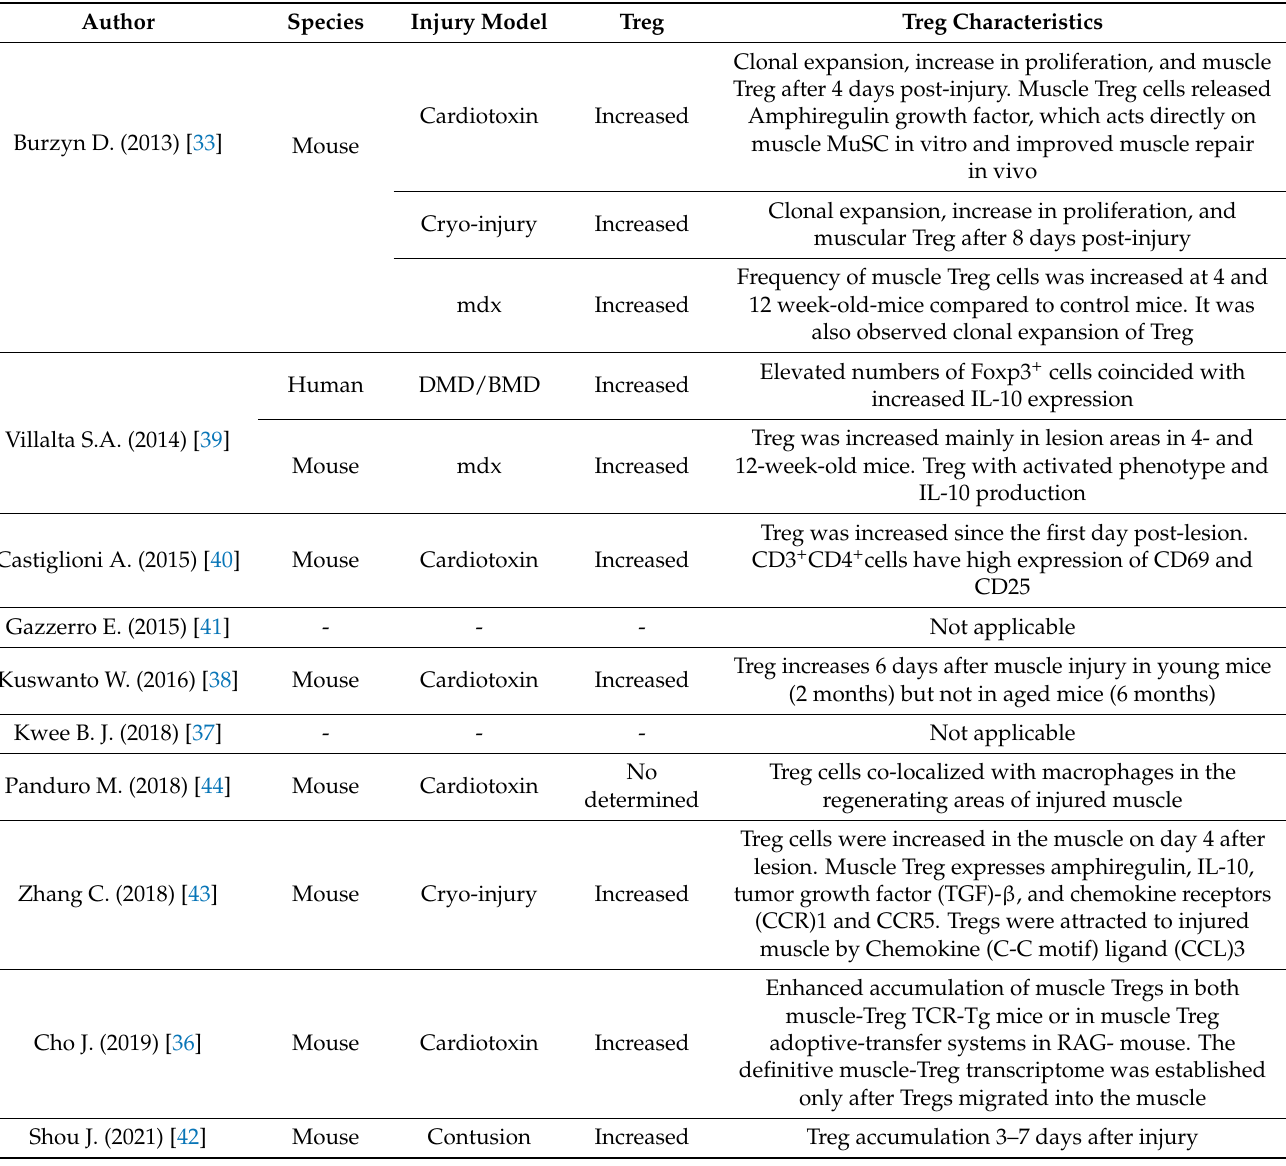
Table 2. Treg levels and their characteristics in muscular